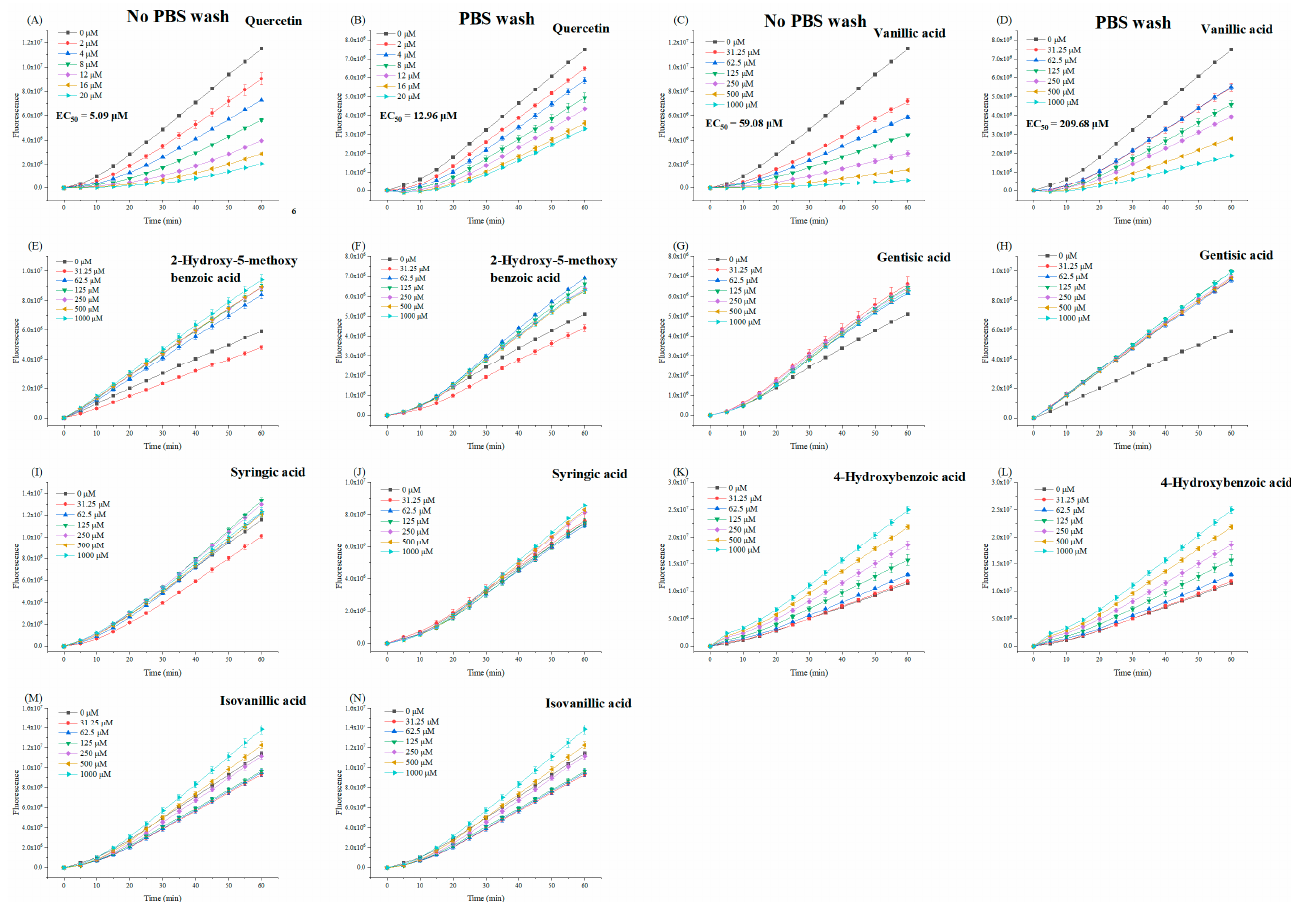
Figure 3. Cellular antioxidant activity of quercetin, vanillic acid, 2-hydroxy-5-methoxybenzoic acid, gentisic acid, syringic acid, 4-hydroxybenzoic acid and isovanillic acid without PBS wash ( A , C , E , G , I , K , M ) and with PBS wash ( B , D , F , H , J , L , N ).